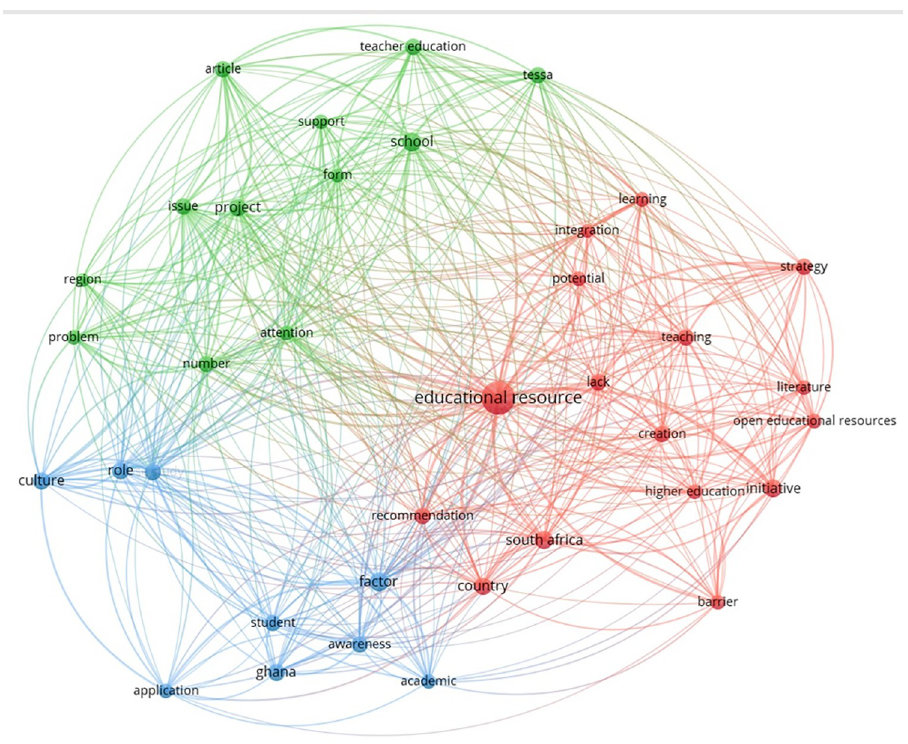
Fig 6. Co-occurrence network map of terms found in titles and